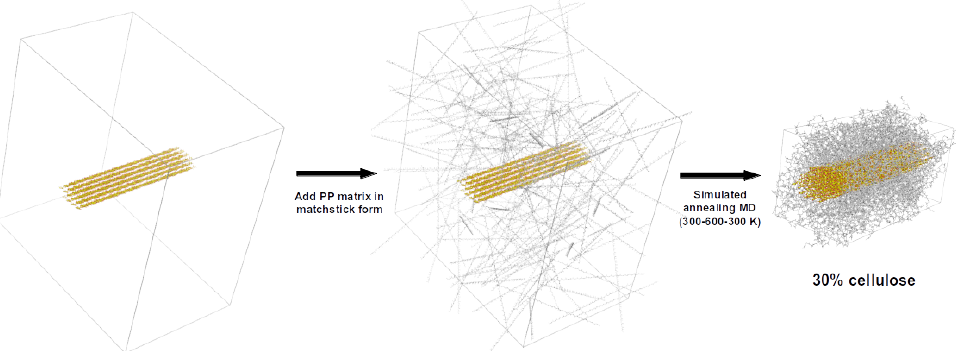
Figure 4. Left : Initial structure model for CNF30-PP50 bionanocomposite model (30% cellulose by weight; PP chains with 50 monomers). Center and right : Modelling steps implemented to generate CNF30-PP50 biocomposite structure models with 30% cellulose by molecular weight. The initial CNF30 and PP50 structures are generated using the Cellulose builder and CHARMM-GUI package, respectively (see text for